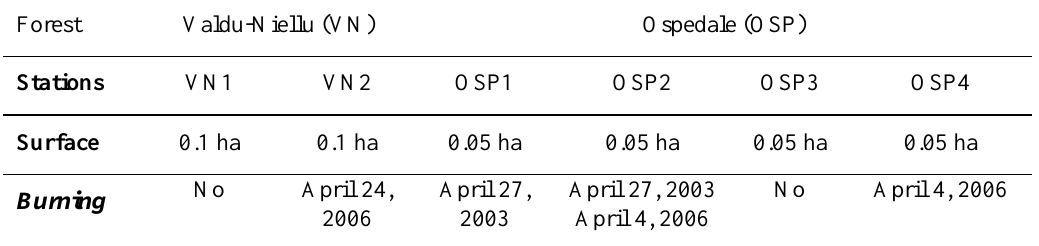
Table 3. The study stations and data concerning the prescribed burnings in the Pinus laricio